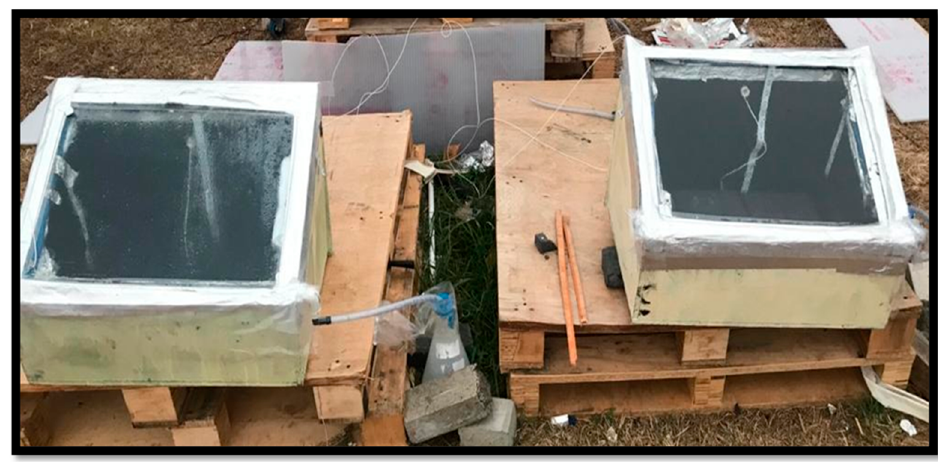
Figure 2. Experimental setup of con-still ( left ) and mod-still ( right ).